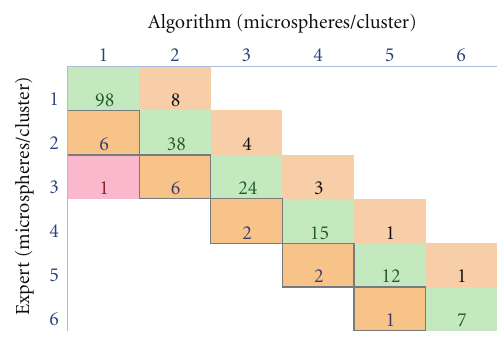
Figure 6: Contingency table analysis of algorithm accuracy on microsphere images. Microspheres/cluster were estimated using the algorithm on working-resolution images (7x). An expert visually determined the number of microspheres/cluster on corresponding high-resolution images (63x). Table entries are the number of times a result was obtained; for example, the algorithm and expert identified the same 2-cell clusters 38 times. In all cases but one, the algorithm was within ± 1 microspheres. The total number of microspheres counted by the expert was 499 compared to 497 by the algorithm.